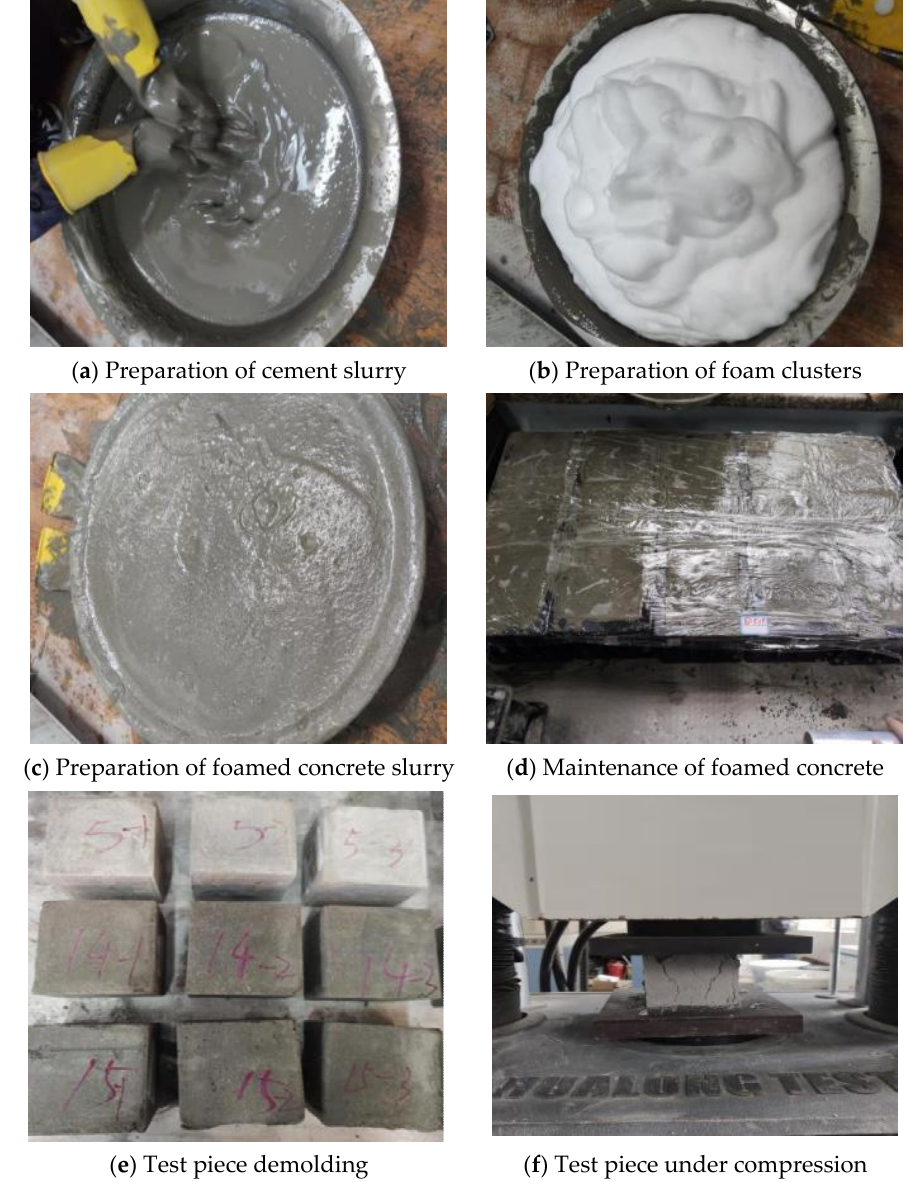
Figure 8. Schematic of test. Table 1. Test value of the compressive strength of foamed concrete test